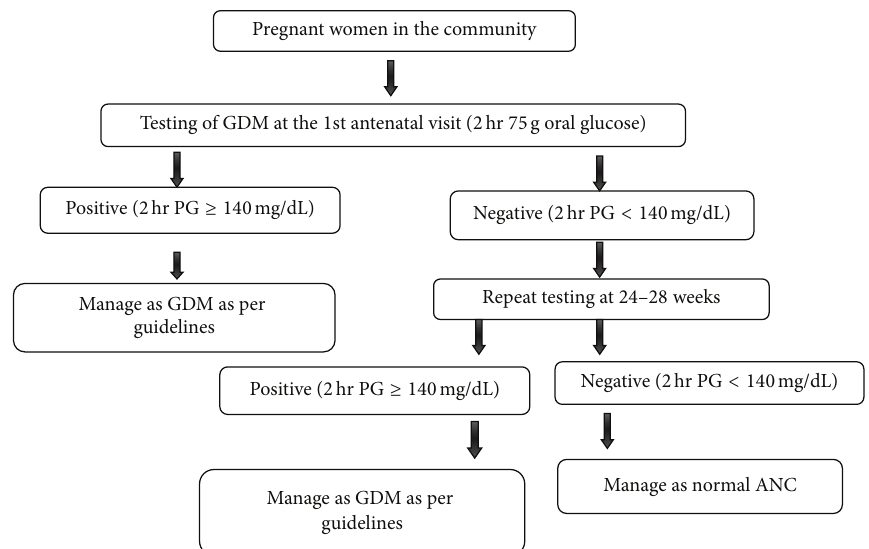
Figure 2: National Guidelines for Diagnosis and Management of Gestational Diabetes Mellitus, Government of India, 2014